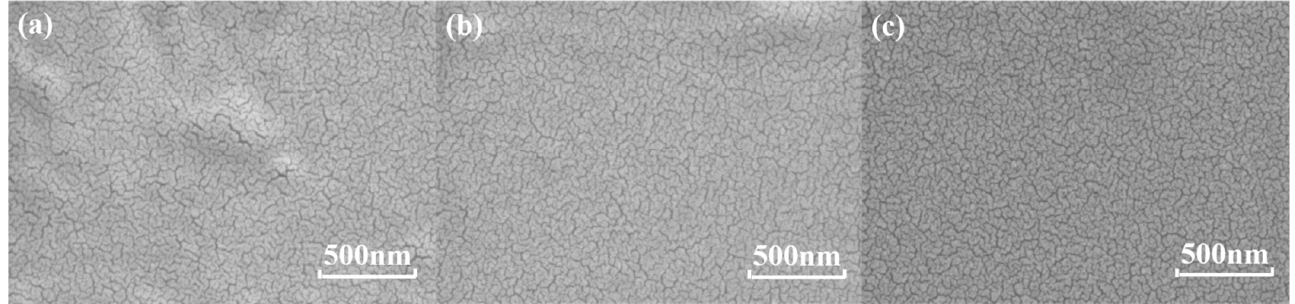
Figure 1. SEM images of the YbF 3 films prepared at different ion energies. ( a ) 0 eV. ( b ) 180 eV. ( c ) 360 eV.